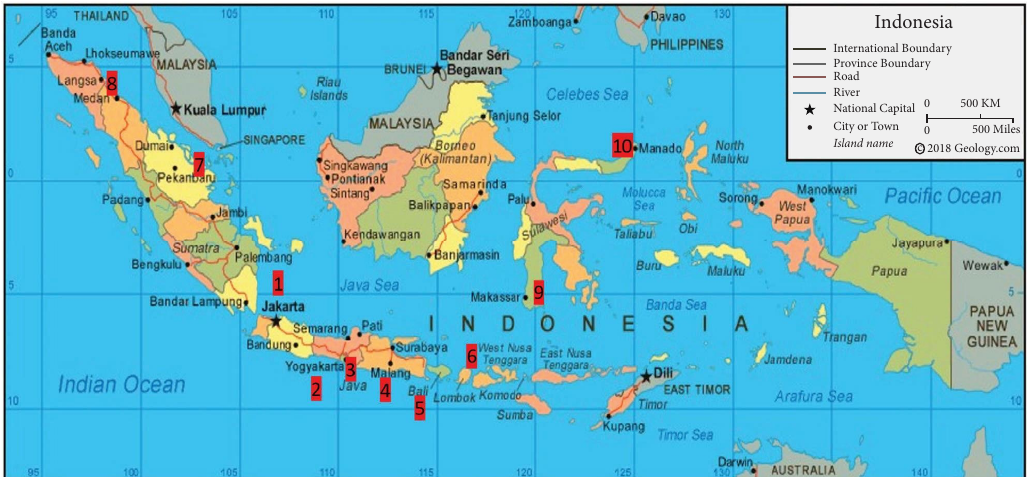
Figure 1: Study sites. Sources of picture: